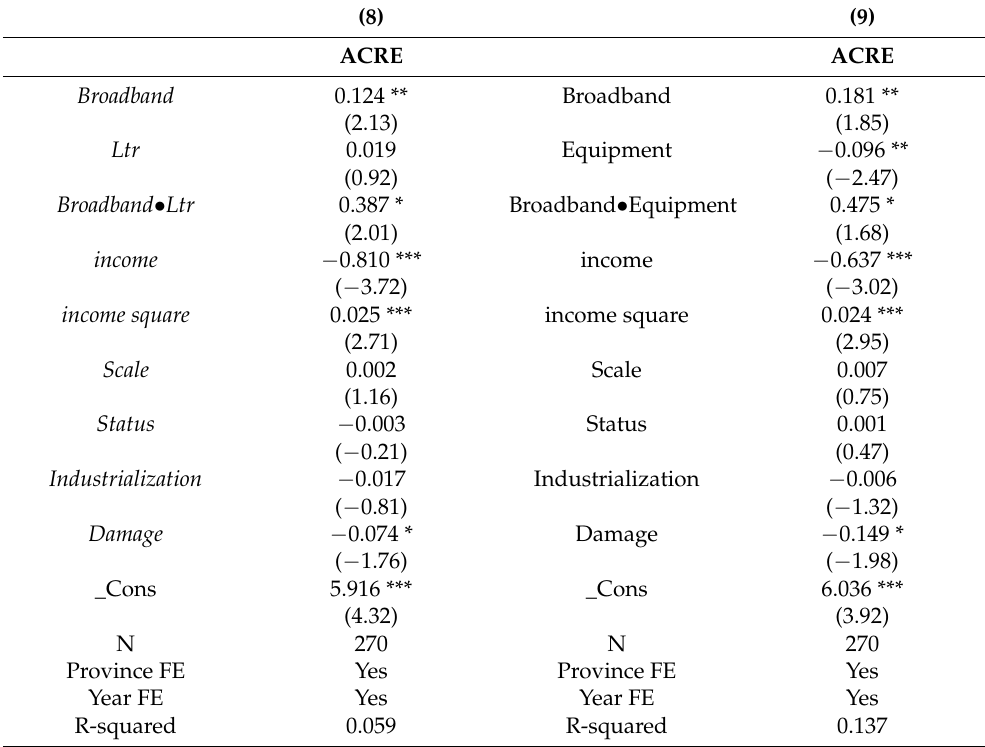
Table 8. Moderating effect